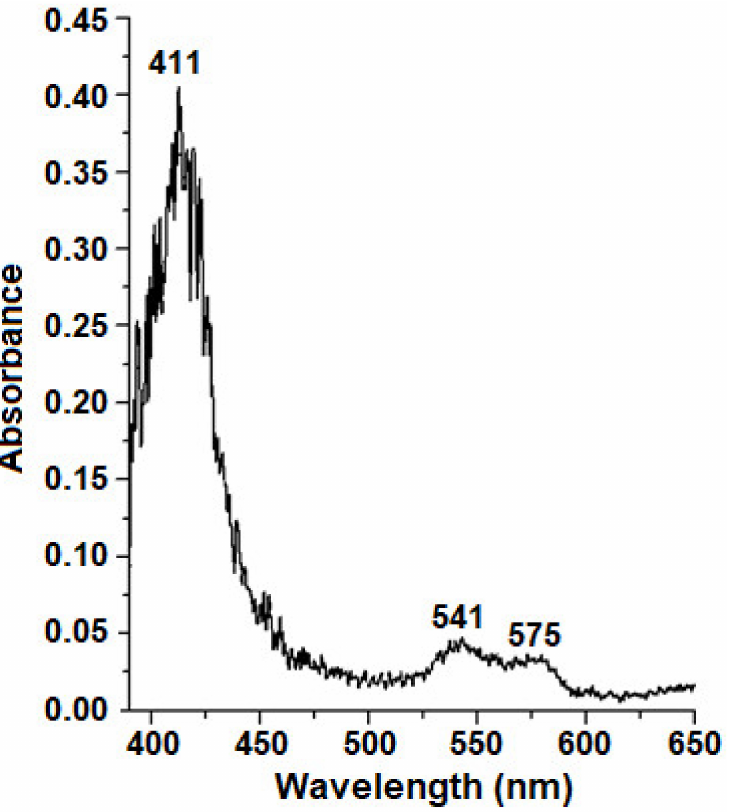
Figure 1. The absorption spectra of E. coli cells washed from medium, representing the difference between spectra of actively synthesizing Lb a cells (C Lb++ ) and nonsynthesizing Lb ones (C Lb − ): the spectrum of C Lb++ cells minus the spectrum of C Lb −